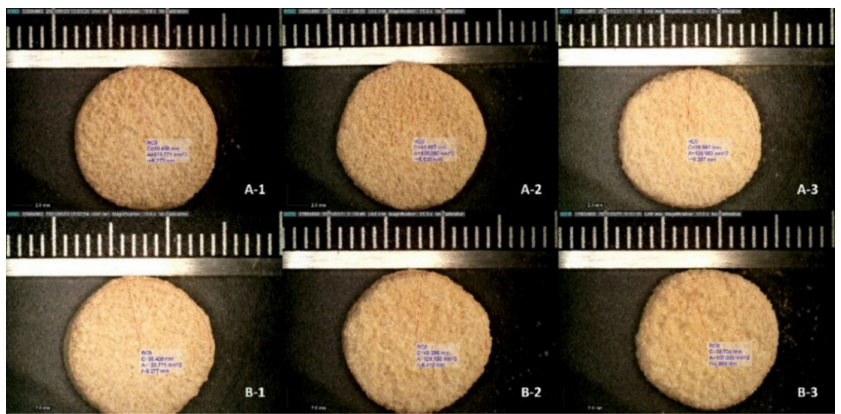
Figure 4. Digital microscopy of SLS 3D printed tablets from PFS and UFS ( A-1 ) 50 mm/s PFS, ( A-2 ) 75 mm/s PFS, ( A-3 ) 100 mm/s PFS, ( B-1 ) 50 mm/s UFS, ( B-2 ) 75 mm/s UFS, ( B-3 ) 100 mm/s UFS. (Each bar is 1